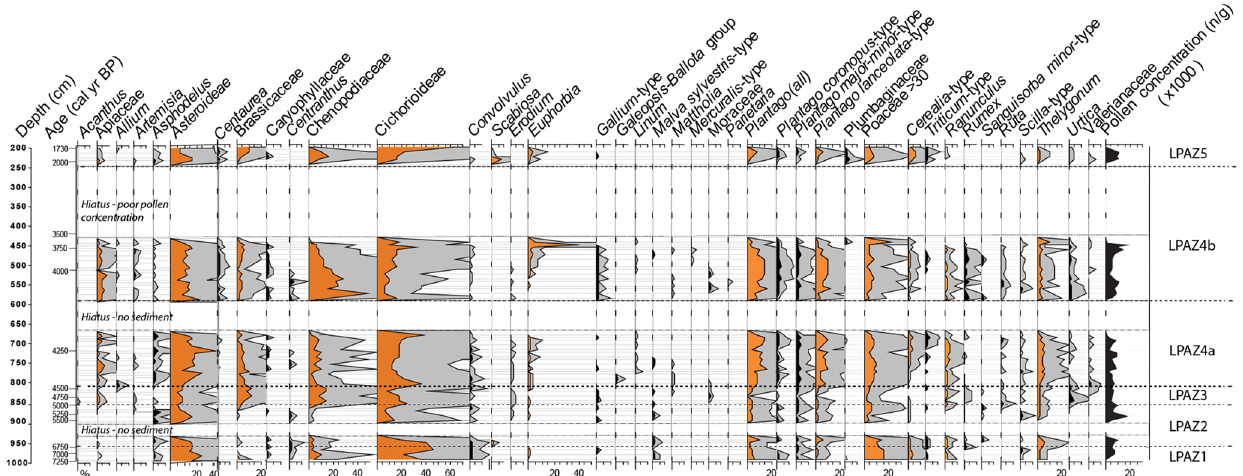
Figure 5. Burmarrad pollen percentage diagram versus depth: herbaceous taxa. The pollen percentages are calculated using the pollen sum of all terrestrial pollen counted; it excludes Cyperaceae and other aquatic/hygrophilous species, NPPs, and undetermined/indeterminable